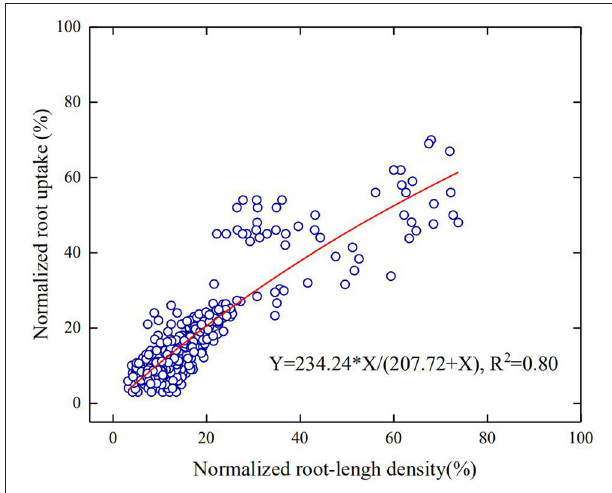
FIGURE 6 | The increase in the normalized root water uptake rate with the normalized root-length density for all treatments in the 2-year experiment.